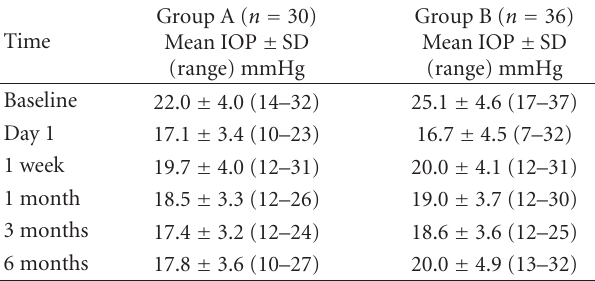
Table 4: IOP variation in group A and group B at baseline and at various times after the SLT